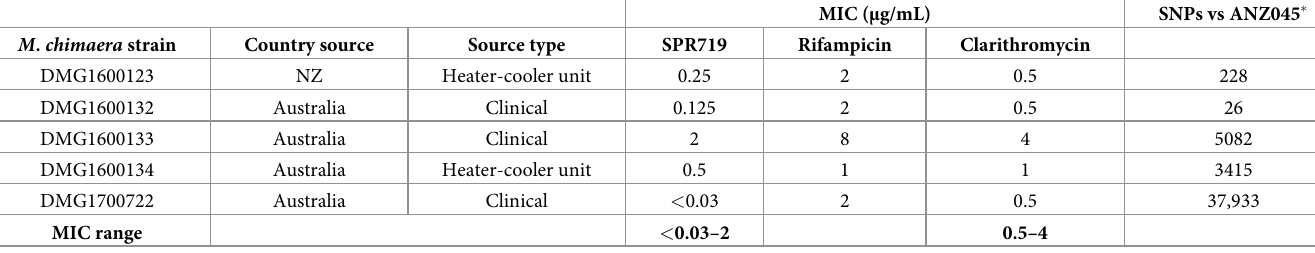
Table 3. M . chimaera strains used in this study, their MICs and a summary of genomic